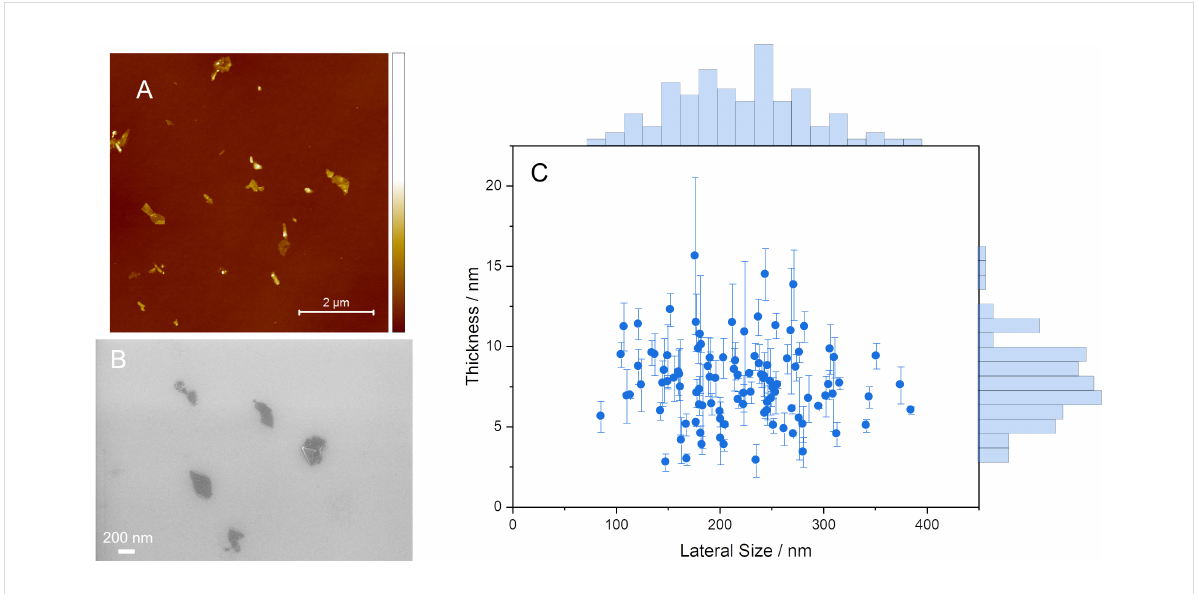
Figure 1: (A) Example AFM image of flakes from the GNP ref sample; the scale bar is 2 μ m. (B) Example SEM image of flakes from the GNP ref sam- ple; the scale bar is 200 nm. (C) Flake sizes of GNP ref sample measured by AFM with histograms of the lateral size and thickness distributions.